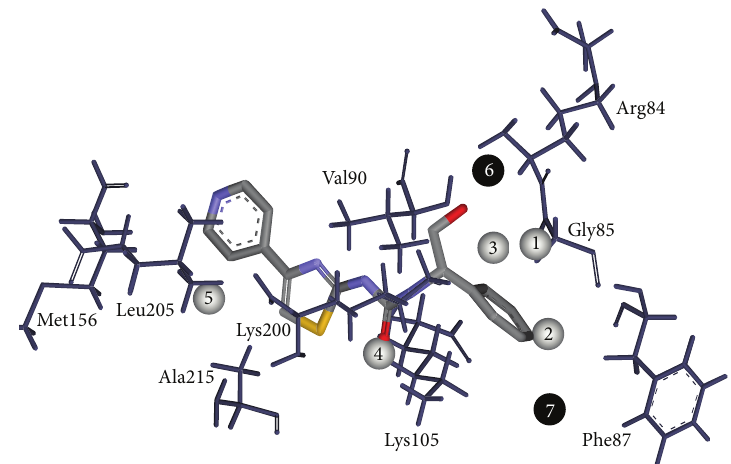
Figure 5: Representation of amino acid residues in the most active molecule ( 18 ). The grey and black spheres represent the positive and negative GCODs, respectively. (1) ( 3,3, −3, np ) ; (2) ( 1,4, −1, ar); (3) ( 2, 3,1, np); (4) ( 0,1, −1, ha); (5) ( 0, −2,1, np); (6) ( 4, 2, −2, ar); and (7) ( 0,4, −3,